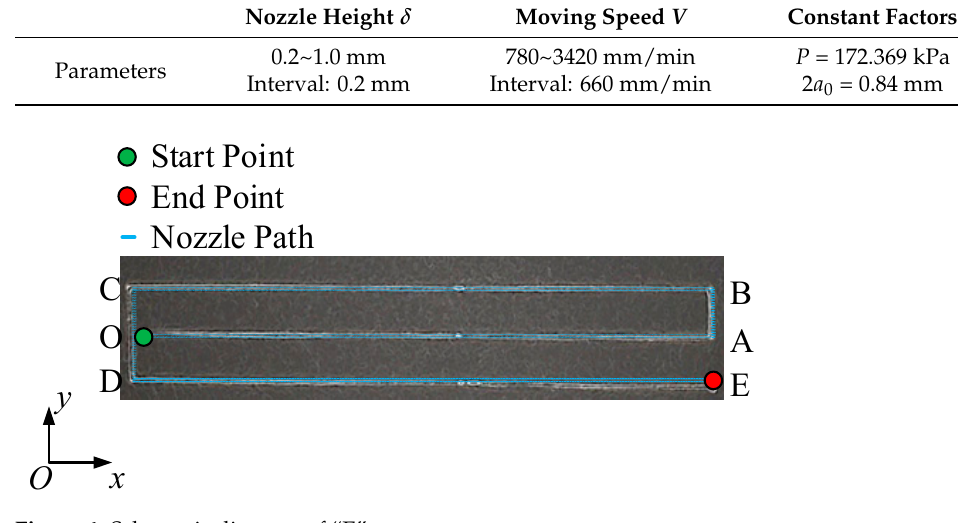
Figure 4. Schematic diagram of “E” pattern.